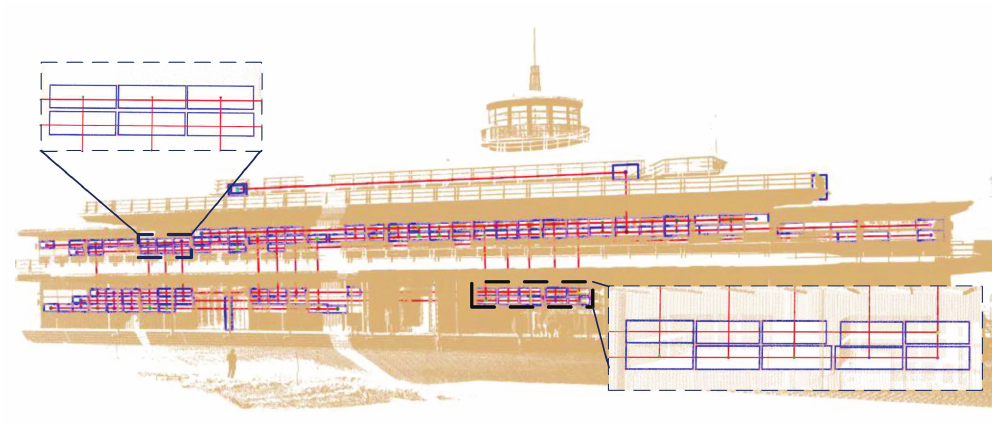
Figure 9. Facade opening detection and association on a static terrestrial LiDAR point cloud. Upper left shows the optimization of alignment and geometry of openings. The figure in lower right illustrates the influence on the optimization by occlusions.